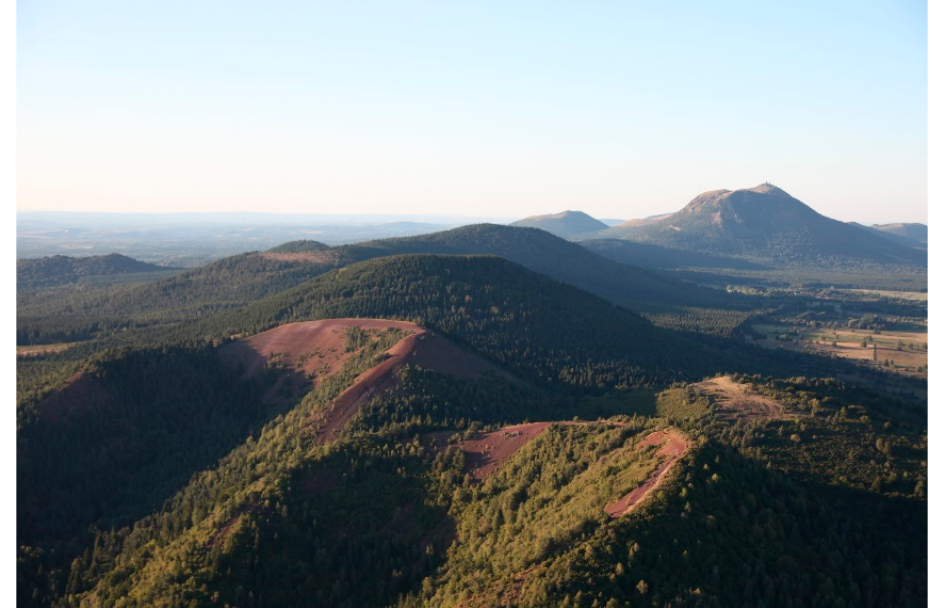
Figure 2. Chain of scoria cones in the Chaîne des Puys volcanic area.